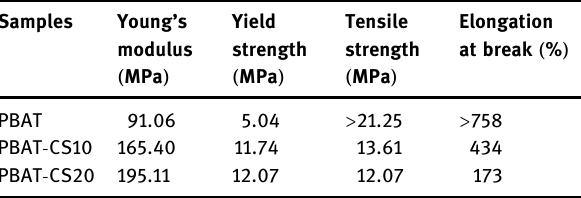
Table 1: The mechanical properties of PBAT, PBAT - CS10, and PBAT - CS20